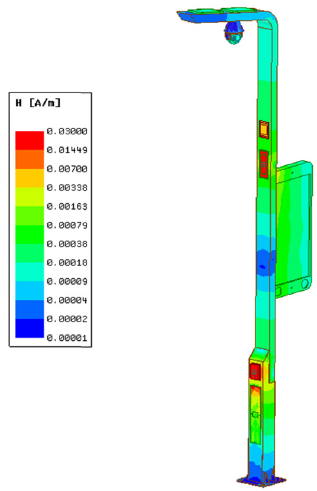
Figure 10: The cloud diagram of the magnetic fi eld intensity distri - bution of the overall